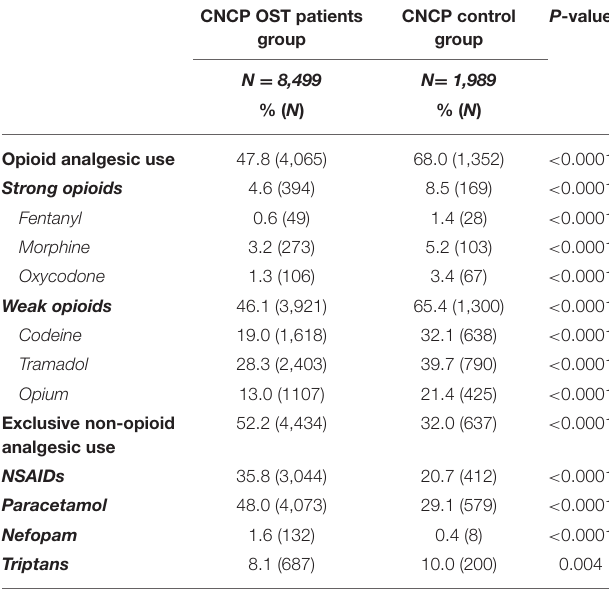
TABLE 2 | Comparison of analgesic drug prescription between chronic non-cancer pain opioid substitution treatment (CNCP OST) patients group and CNCP control